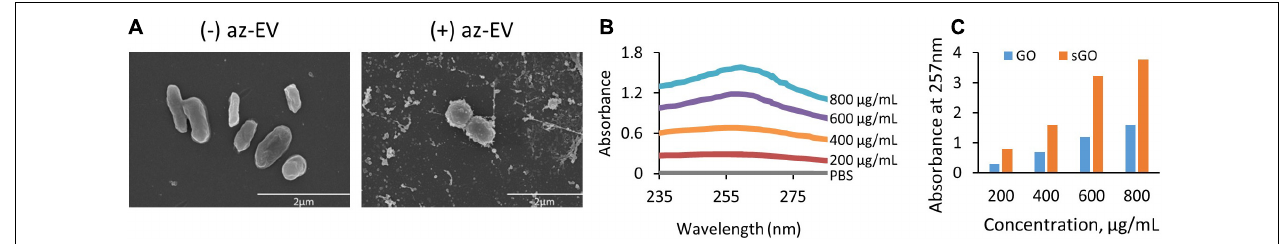
FIGURE 2 | Visualization and absorbance scanning of GO biomaterials. (A) Scanning electron microscopy images of GO and GO-EV were captured at 25 and 20 k magnification, respectively. (B) Absorbance scanning of GO dilutions over 200–300 nm revealed peak absorbance at 257 nm. (C) Absorbance of GO and sGO dilutions at 257 nm.